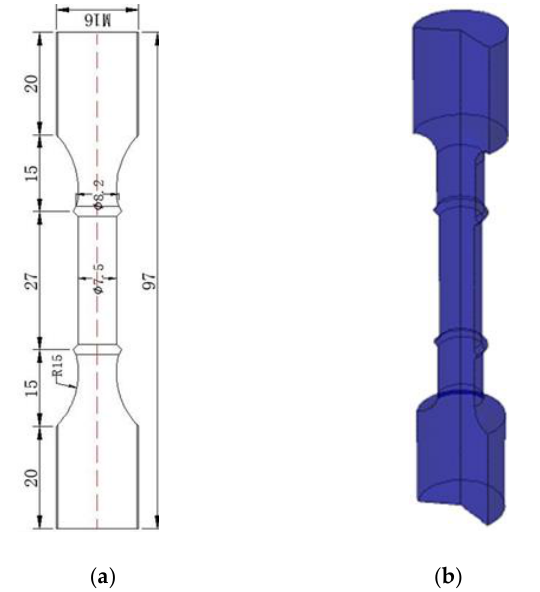
Table 3. Performance parameters of 63Sn–37Pb tin-lead solder at a strain rate of 0.5% s −1 .